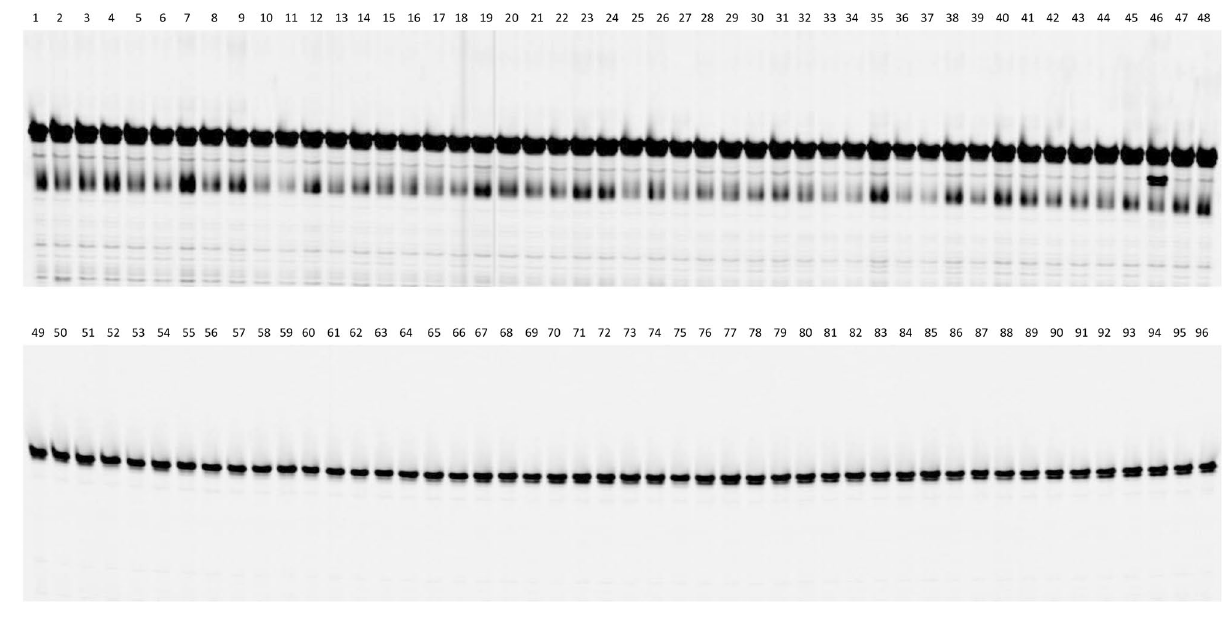
Figure 5. Cropped gel image from PCR amplification of SNP marker C13_175260181 diagnostic for Rf5 on a panel of 96 diversified sunflower lines including lines with Rf1 and Rf7 (Supplementary Table S1). Lane 37 is RHA428 with Rf7 ; lane 46 is HA-R9 carrying Rf5 and R 11 , and lane 49 is RHA 464 with Rf1 . Diagnostic bands were 97 and 102 bp in length including 21/26 bp tail primer, respectively. Full-length gels are presented in Supplementary Figure S2.